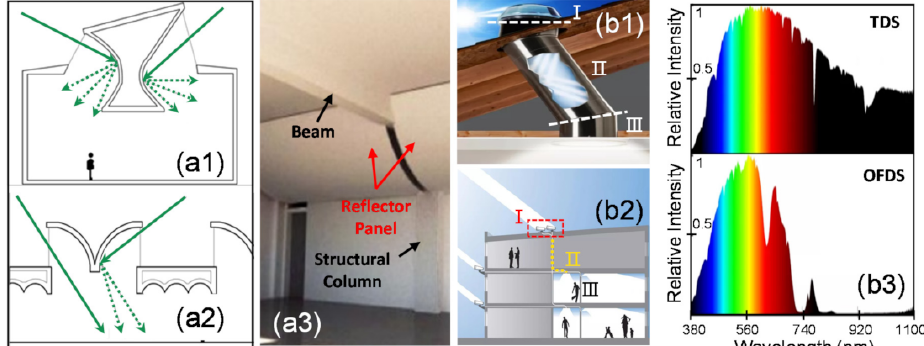
Figure 5. ( a ) Application of reflectors: ( a1 ) Nordic Art Museum, Denmark [101]; ( a2 ) The Meet Foundation Museum in France [101]; ( a3 ) classrooms in a Chinese university [100]. ( b ) Light duct lighting system: ( b1 ) tubular daylighting system (TDS) principle [102]; ( b2 ) optical fiber daylighting system (OFDS) principle [103]; ( b3 ) spectral analysis